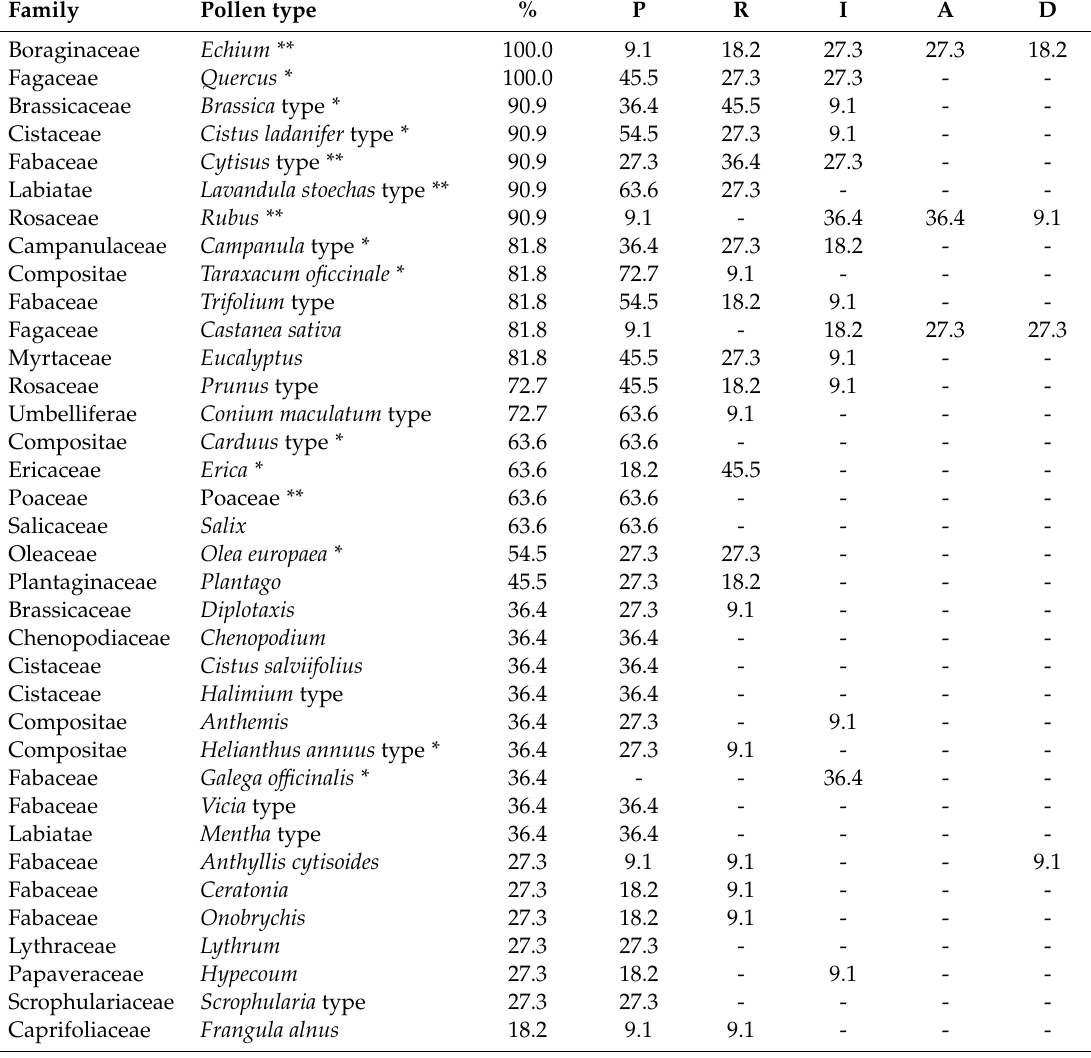
Table 2. Percentage of representation and frequency classes of the main pollen types in evergreen oak honeydew